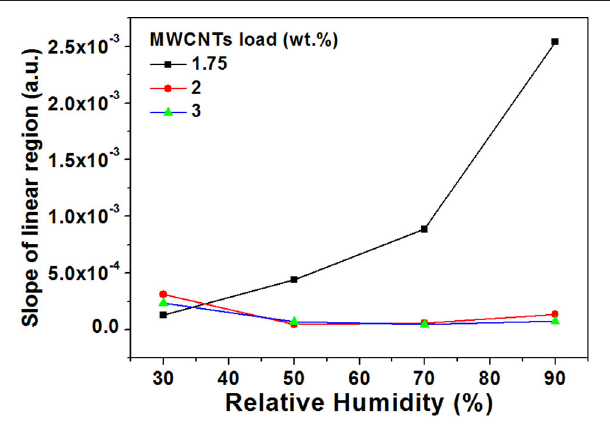
FIGURE 7 | Slope of the linear region at the beginning of the response after the exposure of 0.3mm thin SEBS-MA-PEG/MWCNT-P samples to various ∼ R. H. levels.